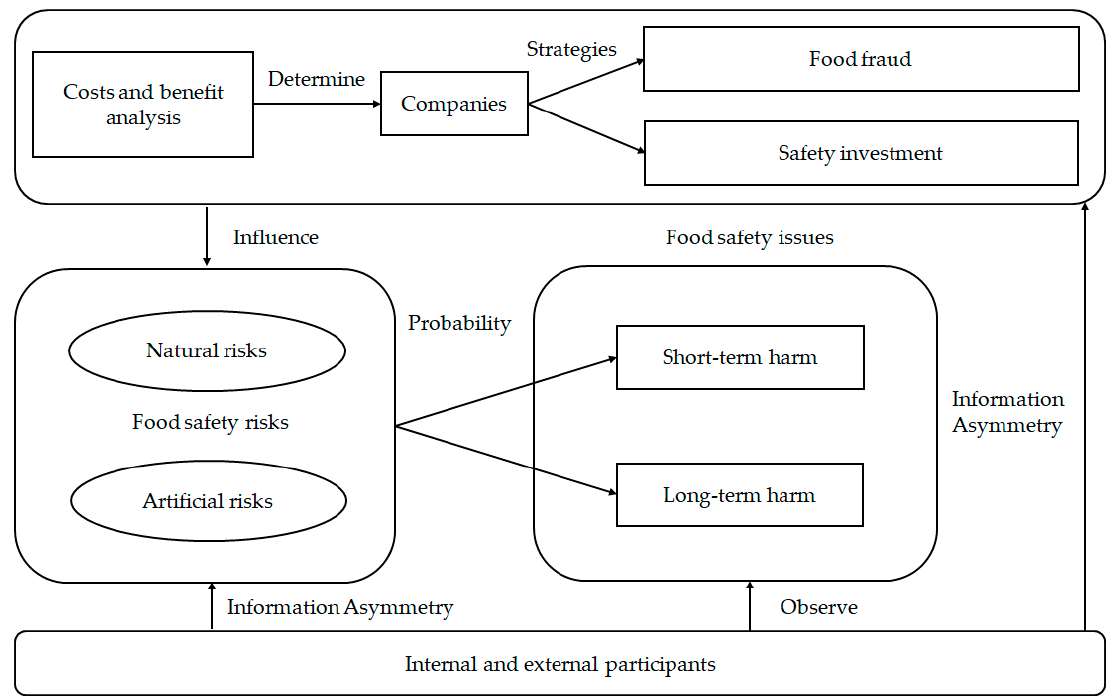
Figure 1. Relationship between food safety risks, companies’ strategies, as well as food safety issues.